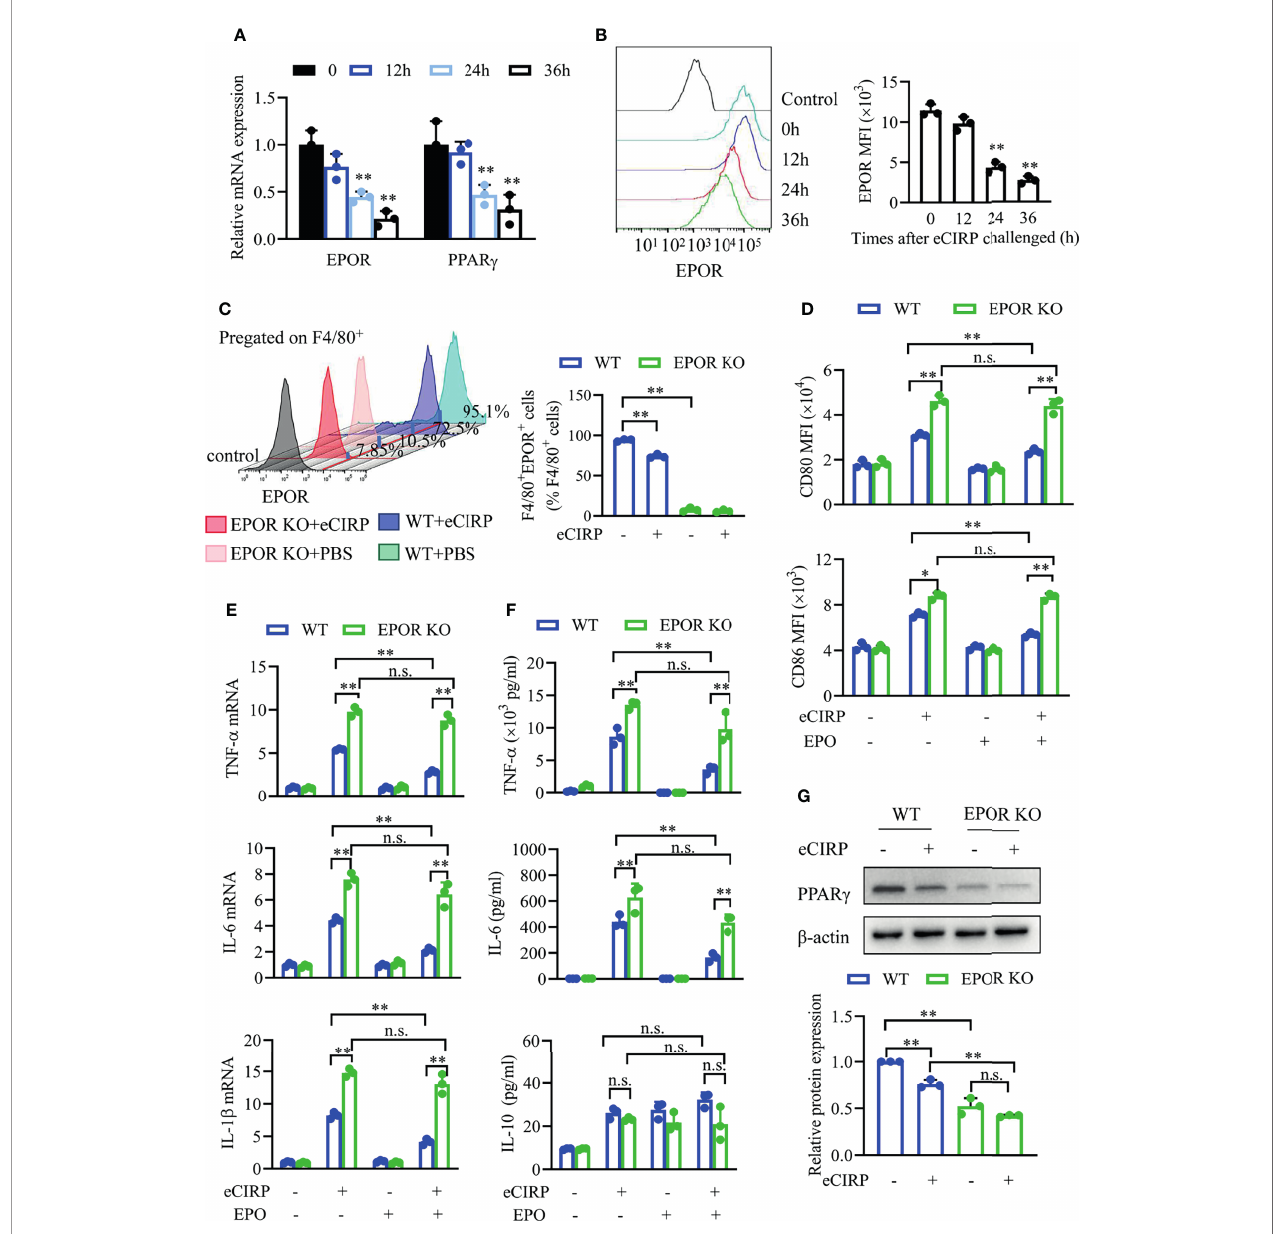
FIGURE 4 | Myeloid EPOR signaling is essential for macrophage polarization. (A) A qPCR assay was conducted to evaluate the mRNA expression of EPOR and PPAR g after WT BMDMs were treated with eCIRP for the indicated times (n = 3). (B) The MFIs of cell surface EPOR in BMDMs treated with eCIRP for the indicated times were tested by FACS (n = 3). ** P < 0.01 vs. 0 h group. (C) The percentage of EPOR + cells in WT and EPOR cKO BMDMs treated with or without eCIRP for 24 h (n = 3). (D) The MFIs of CD80 and CD86 in WT and EPOR cKO BMDMs were measured by FACS with or without eCIRP (1 µg/ml) and rhEPO (20 IU/ml) administration (n = 3). (E) A qPCR assay was conducted to evaluate the mRNA expression of TNF- a , IL-6, and IL-1 b in WT and EPOR cKO BMDMs with or without eCIRP and rhEPO (20 IU/ml) administration (n = 3). (F) The supernatant concentrations of TNF- a , IL-6, and IL-10 in BMDMs were measured with or without eCIRP (1 µg/ml) and rhEPO (20 IU/ml) administration (n = 3). (G) Western blot analysis of PPAR g and b -actin protein expression was conducted after WT and EPOR cKO BMDMs were treated with eCIRP for 24 h (n = 3). Data are representative of at least two independent experiments. Results were expressed as mean ± SD. n.s., not statistically signi fi cant. * P < 0.05, ** P < 0.01. Statistics: One-way ANOVA with Tukey ’ s post-hoc test for multiple comparisons (A – G) . EPOR, erythropoietin receptor; PCR, Polymerase Chain Reaction; PPAR, peroxisome proliferator-activated receptor; BMDM, bone marrow derived macrophage; eCIRP, extracellular cold-inducible RNA-binding protein; WT, wild type; EPO, erythropoietin; MFI, mean fl uorescence intensity; FACS, fl uorescence activated cell